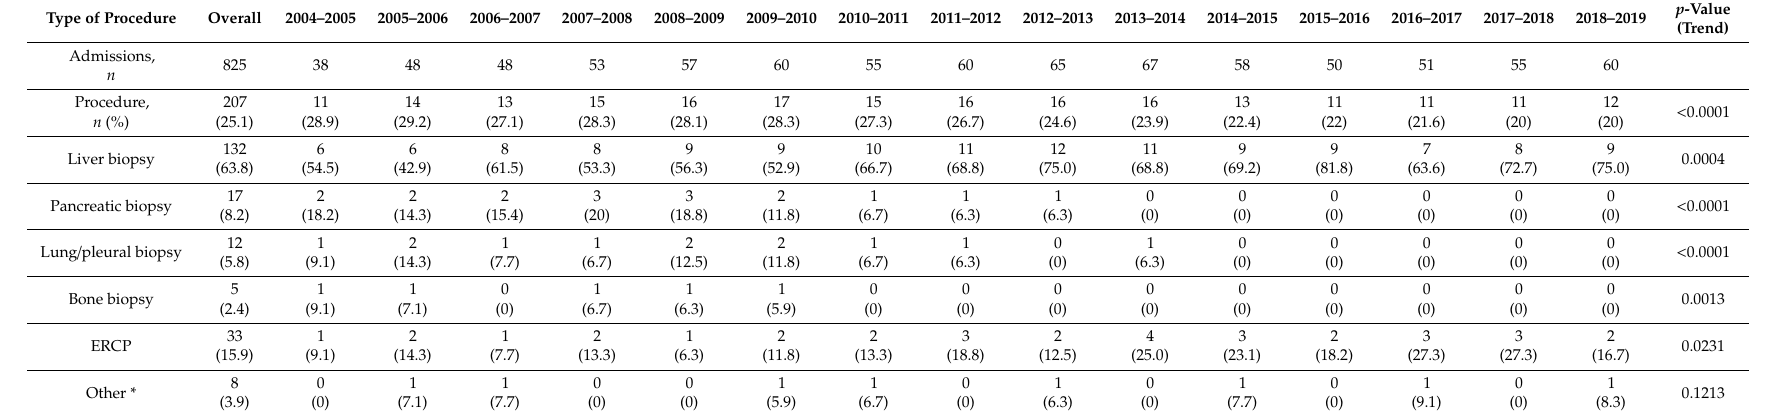
Table 3. Trends in invasive procedures for patients hospitalized from 2004 to